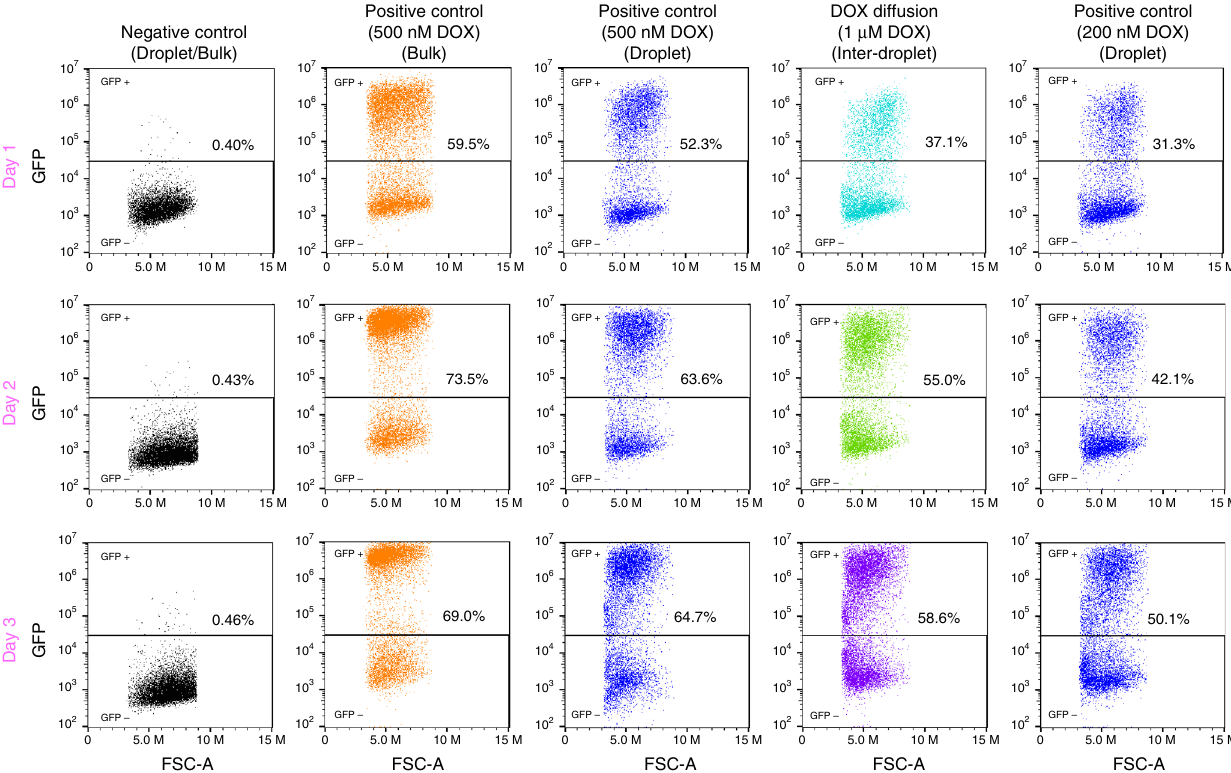
Fig. 5 DOX-inducible GFP-reporter cells to quantify drug transfer. We used the parallel drop maker to generate homogenous mixtures in which 50% of the droplets contained DOX (at the indicated concentrations), 42% contained ≥ 1 cell, and 8% were empty. We incubated droplets at 37 °C for the indicated times, isolated the cells from the droplets, and quanti fi ed the GFP + cells using fl ow cytometer. GFP intensity is plotted against forward scatter-area (FSC- A). For the positive control in bulk, we cultured the DOX-GFP-HEK 293 cells with DOX in six well plates using standard cell culture methods. For the Positive Control (Droplet), all droplets, including those with cells, contained DOX at the indicated